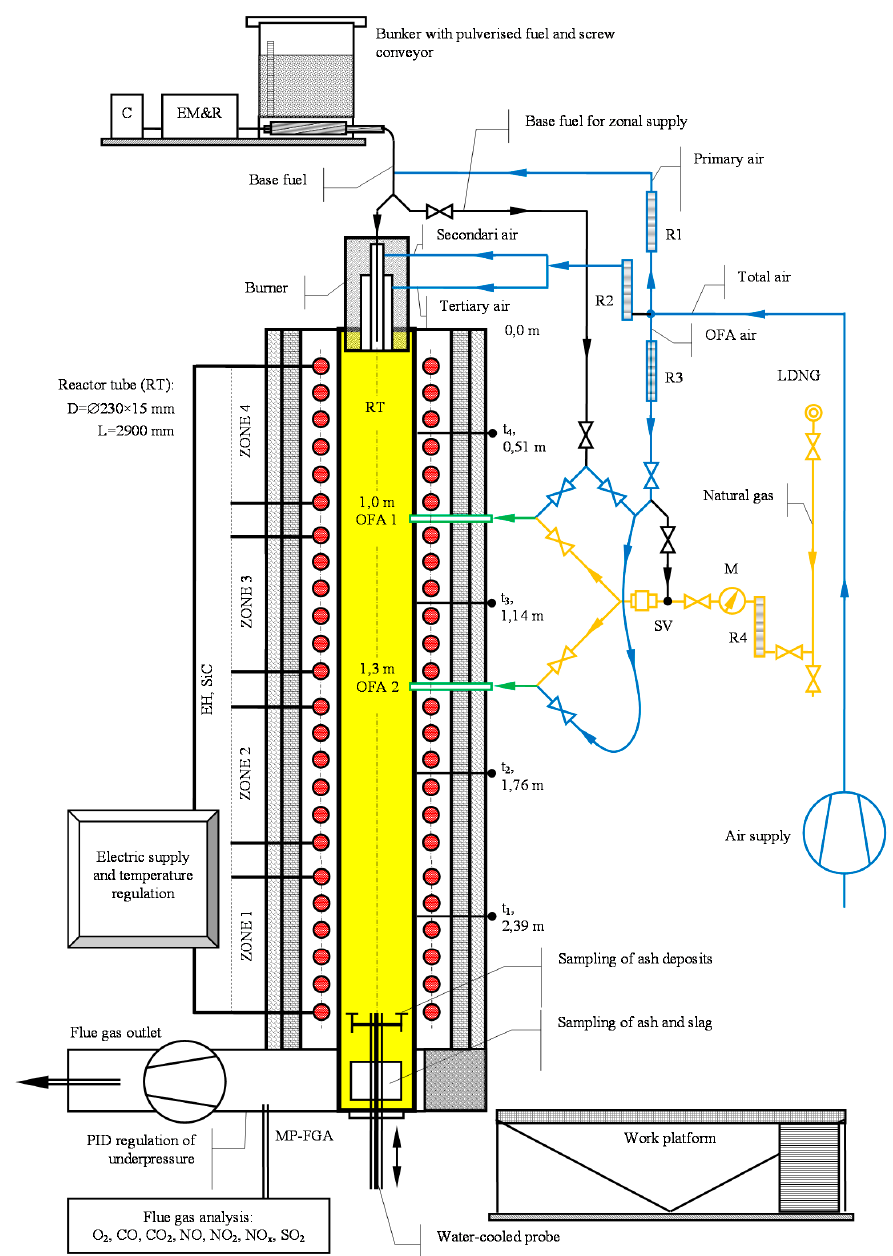
Figure 1. Principal scheme of the experimental furnace; C—speed controller of fuel supply, EM&R—electric motor and gearbox, RT—reaction tube, Ri—flow meters measuring the flow of air and natural gas, EH—SiC electric heaters arranged in four zones/levels, LDNG—laboratory distribution of natural gas, SV—safety valve with integrated flame arrester, M—manometer, MP-FGA—measuring point/flue gas analysis.